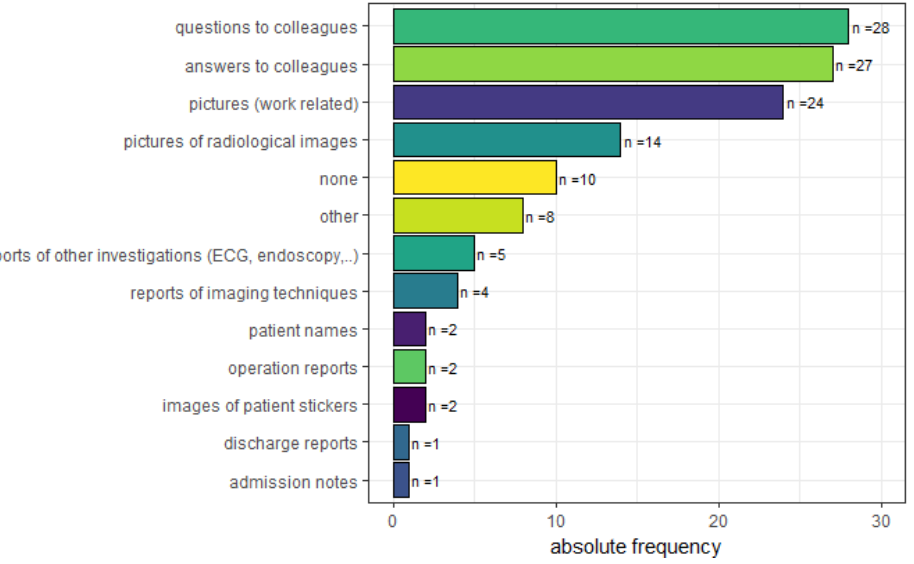
Table 3. Absolute frequencies of the codes assigned (Q16) “What do you see as the benefits of using communication apps in your daily clinical practice?” ( N = 50/70).